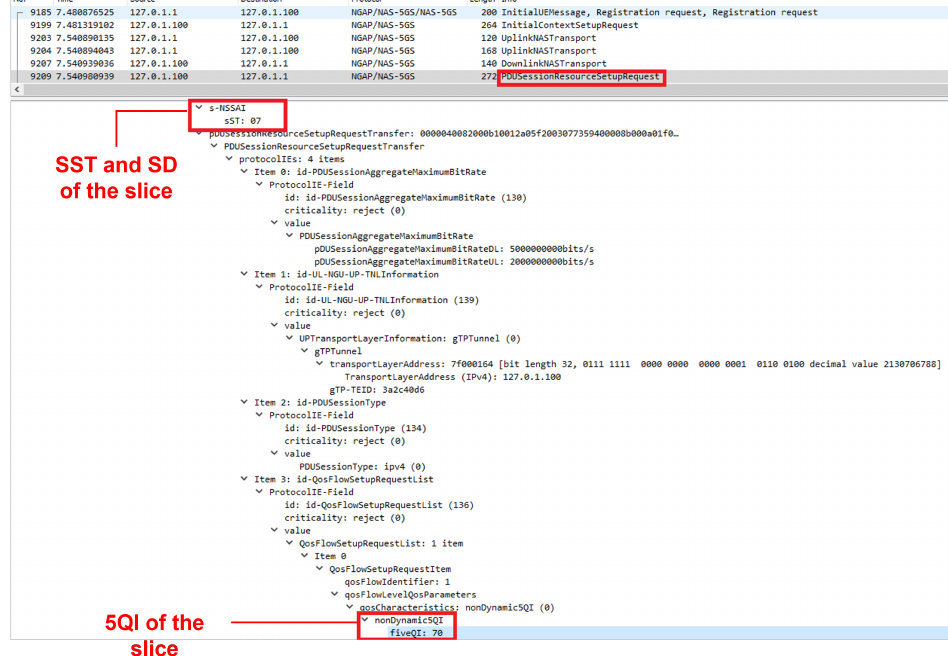
Figure 3. PDU Session Resource Setup Request message with the selected SST and associated